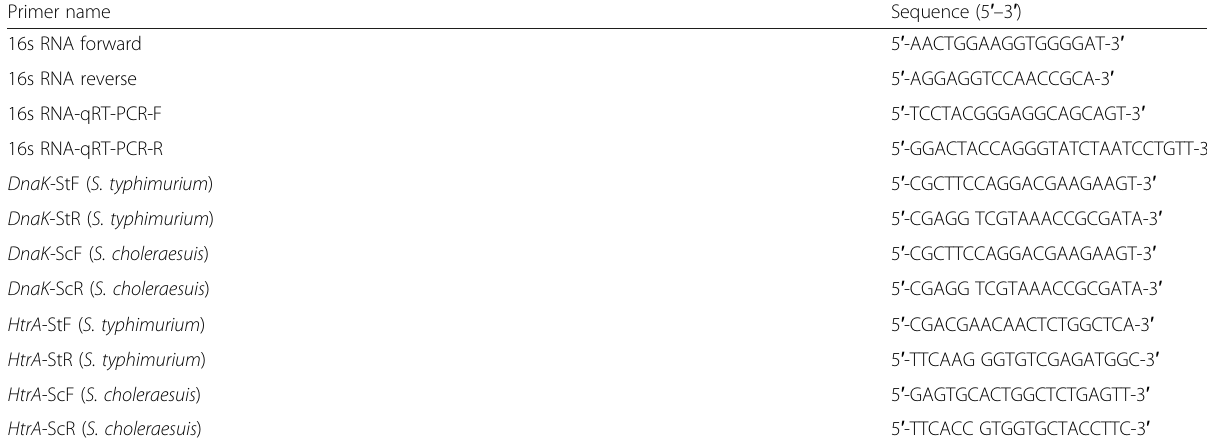
Table 1 Sequences of primers used in this study for 16s bacterial identification and for heat shock gene ( DnaK and HtrA ) expression